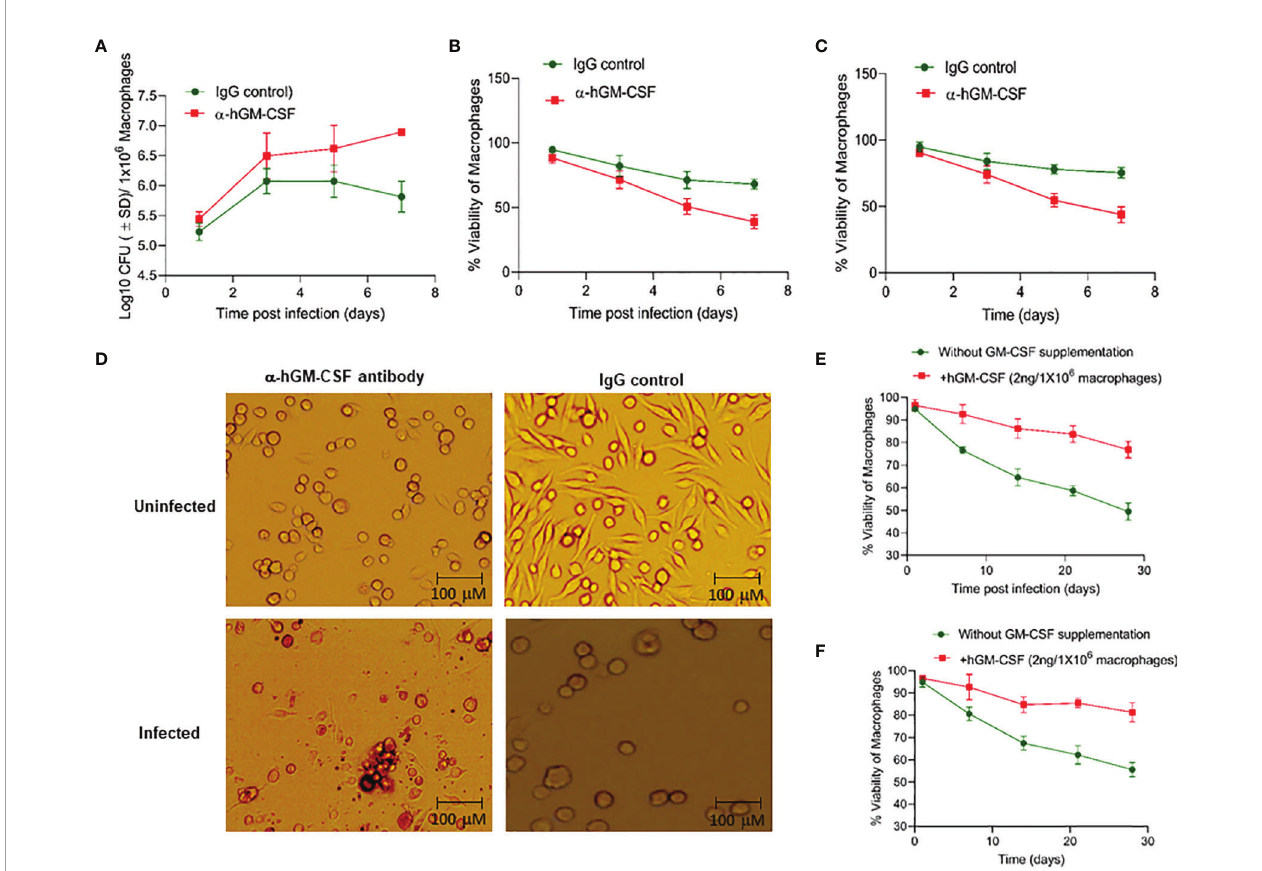
FIGURE 2 | GM-CSF-dependent control of bacterial burden, cell survival, and differentiation of human macrophages during M. tuberculosis infection. (A) M. tuberculosis burden in a -hGM-CSF antibody-treated undifferentiated human macrophages versus IgG isotype-treated undifferentiated macrophages as measured through CFU assay over seven days of infection. Concentration of a -hGM-CSF antibody/IgG isotype used for treatment was 2 m g/10 6 macrophages. (B) Cell viability of M. tuberculosis -infected and a - hGM-CSF antibody-treated undifferentiated human macrophages versus IgG isotype-treated undifferentiated macrophages measured by alamarBlue assay over seven days of infection. (C) Cell viability of a -hGM-CSF antibody-treated undifferentiated human macrophages versus IgG isotype-treated undifferentiated macrophages measured by alamarBlue assay over seven days. (D) Morphology of a -hGM-CSF antibody-treated macrophages versus untreated macrophages with and without M. tuberculosis infection at day 7 post-infection/treatment. Images were acquired at 20x magni fi cation with an inverted bright fi eld microscope using macrophages of a single random healthy donor. (E) Cell viability of -infected and hGM-CSF-treated undifferentiated macrophages versus untreated undifferentiated macrophages measured by alamarBlue assay over seven days of infection. (F) Cell viability of uninfected hGM-CSF-treated undifferentiated macrophages versus untreated undifferentiated macrophages measured by alamarBlue assay over seven days of infection. Data represent average of three independent experiments carried out in duplicate. Bars and error bars represent means and SD,